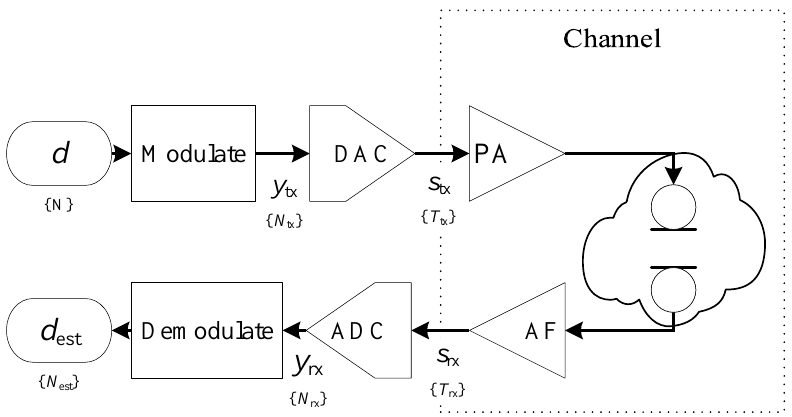
Figure 1. Flow diagram of the basic communication chain: The data d is modulated, amplified before transmission, filtered and amplified at reception, and demodulated as d est . The entire analog domain is regarded as part of the communication